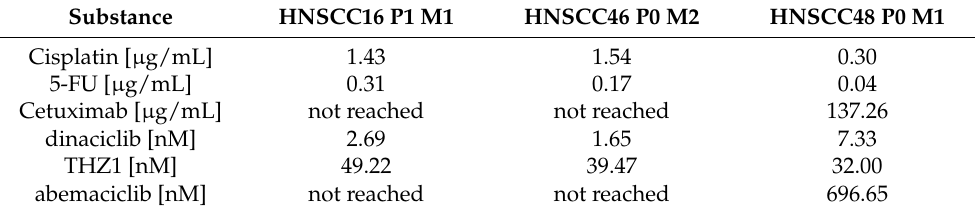
Table 3. IC 50 values of test substances as determined by crystal violet staining.